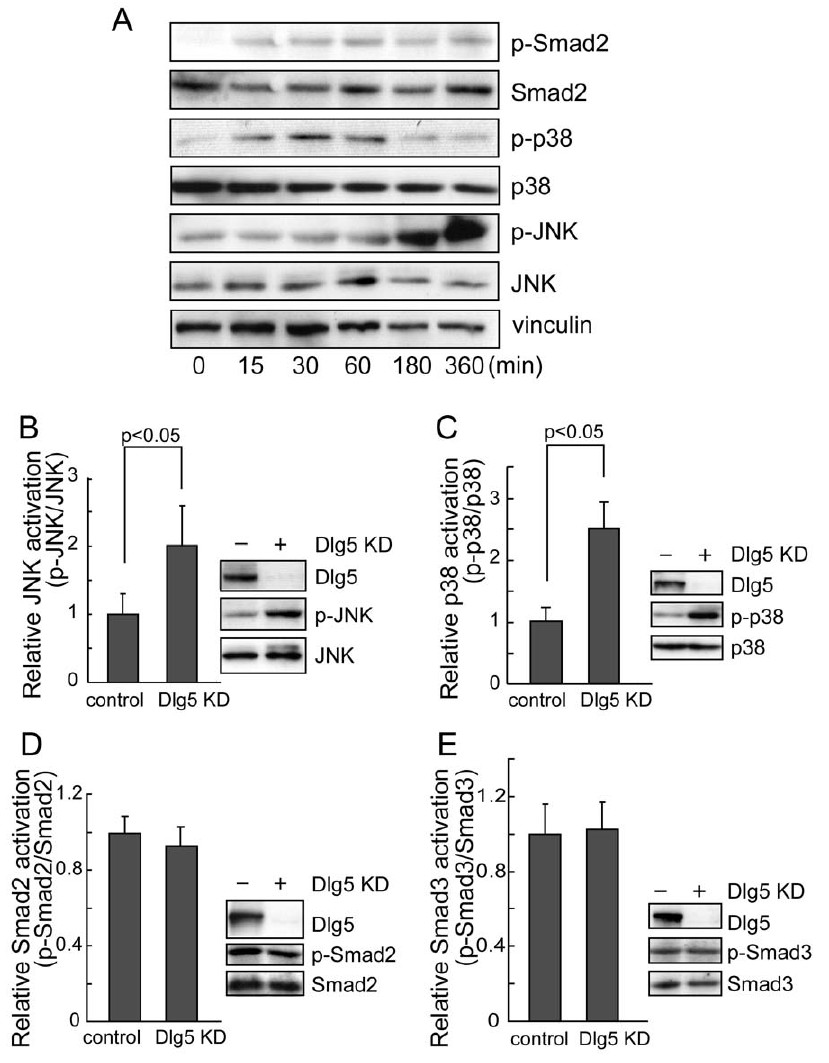
Figure 4. Dlg5 depletion promotes JNK and p38 activation. A: LLc-PK1 cells were stimulated with 4 ng/ml TGF- b and incubated for the indicated periods. Cells were then lysed and immunoblotted using the indicated antibodies. B, C, D, E: LLc-PK1 cells were transfected with Dlg5 siRNA (KD) or control siRNA and incubated for two days. Cell lysates were then immunoblotted using the indicated antibodies, and the results were quantitated. The values represent the mean 6 S.E. from at least three independent experiments. Dlg5 depletion promoted JNK and p38 activation but not Smad2/3 activation.